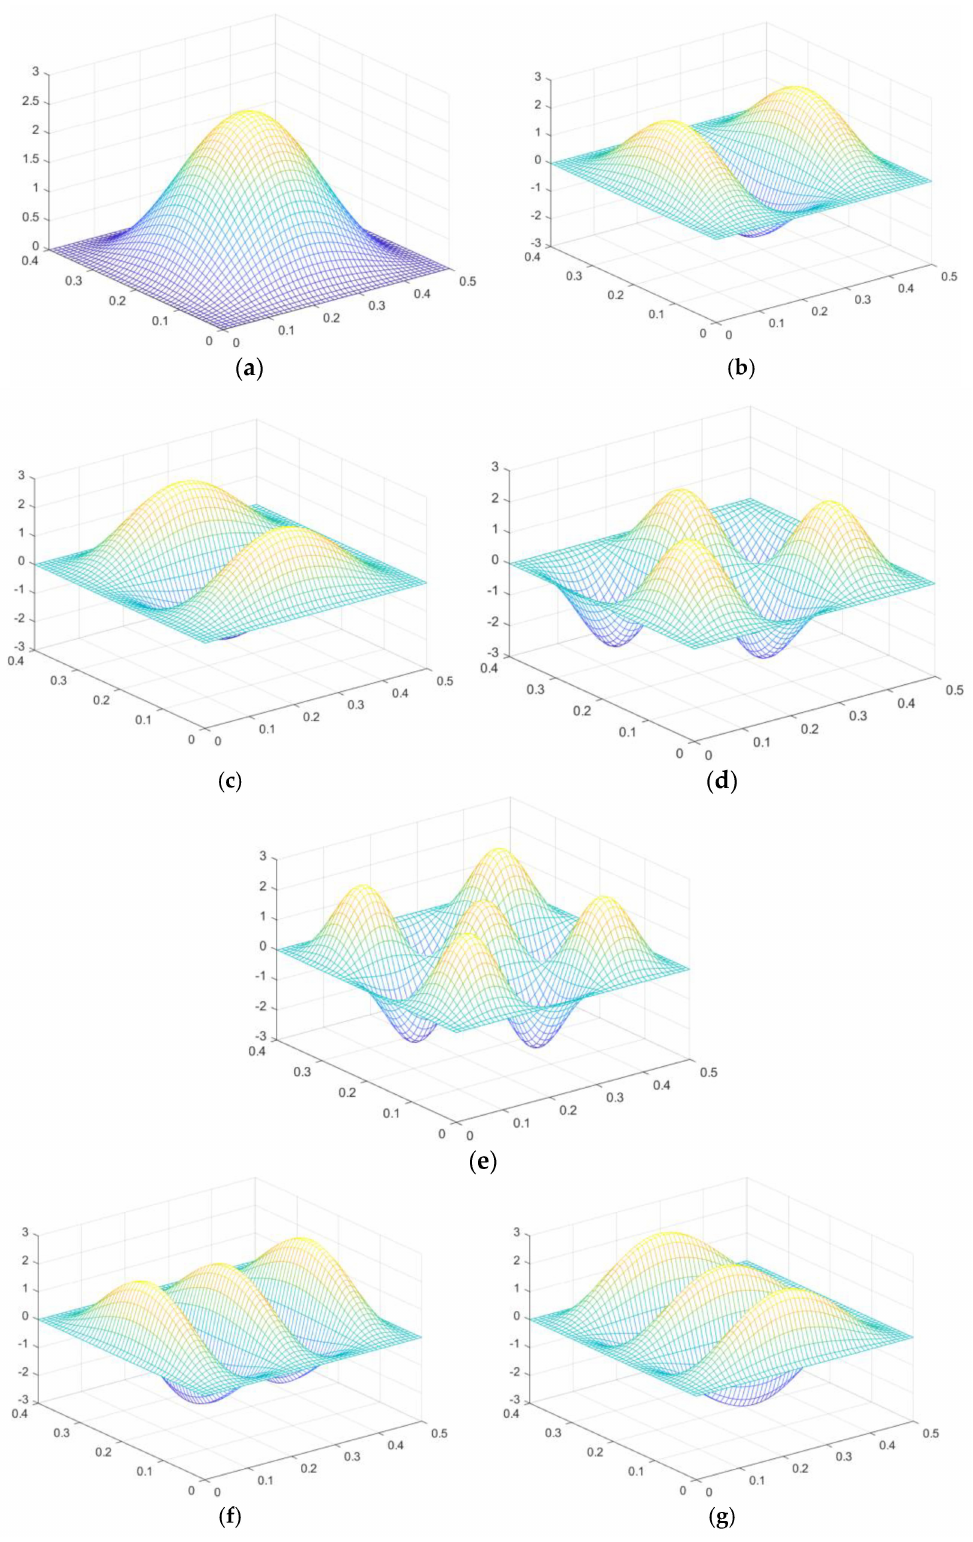
Figure 8. P-FGM plates contributing modes for k = 0. ( a ) Mode [1,1] 256.6 Hz; ( b ) Mode [1,3] 768.74 Hz; ( c ) Mode [3,1] 1102.2 Hz; ( d ) Mode [3,2] 1069.5 Hz; ( e ) Mode [3,3] 1561.9 Hz. ( f ) Mode [5,1] 1754.5 Hz; ( g ) Mode [1,5] 1832.2